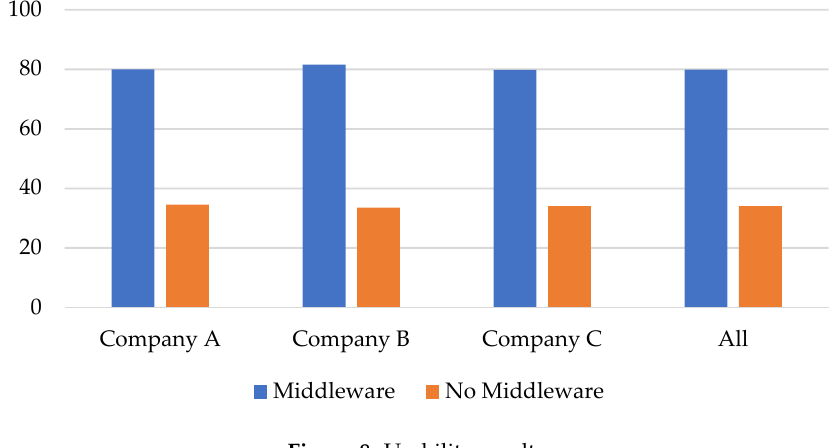
Figure 8. Usability results.